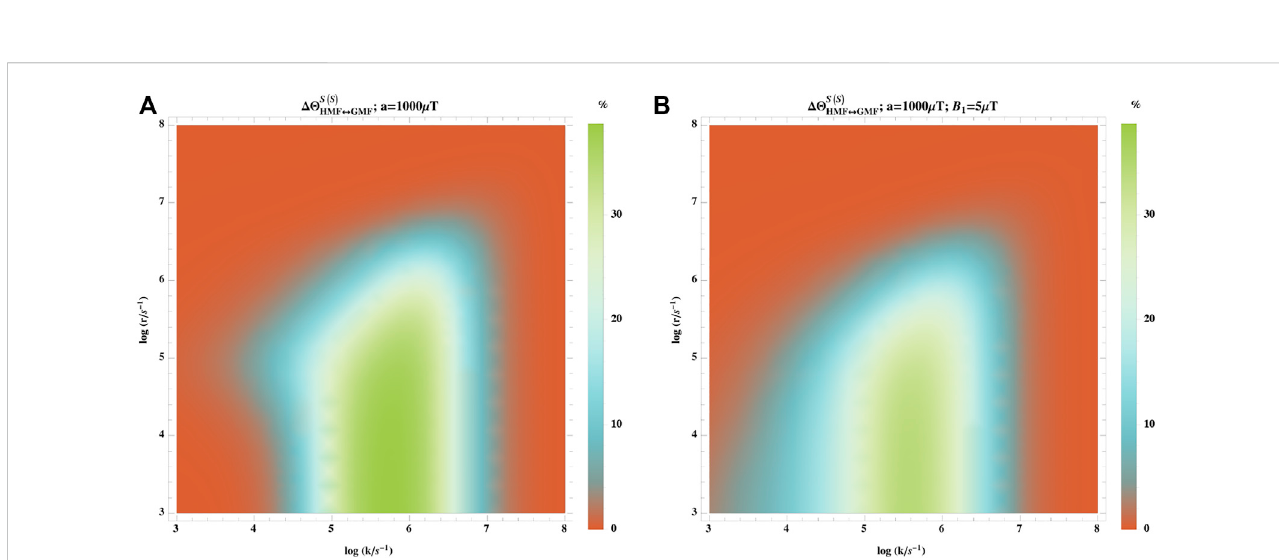
FIGURE 8 Effect of small fl uctuation on the hypomagnetic fi eld effects. The hypomagnetic fi eld effect is based on the singlet yield ratio with initial singlet states without (A) andwith (B) fl uctuatingmagnetic fi eldof5 μ Twithlowfrequency.Inthismodel,oneoftheradicalshasnohyper fi neinteraction,andtheotherone is coupled to an isotropic hyper fi ne coupling constant of a eiso = 1,000 μ T. The fl uctuating fi eld does not change the hypomagnetic fi eld effects signi fi